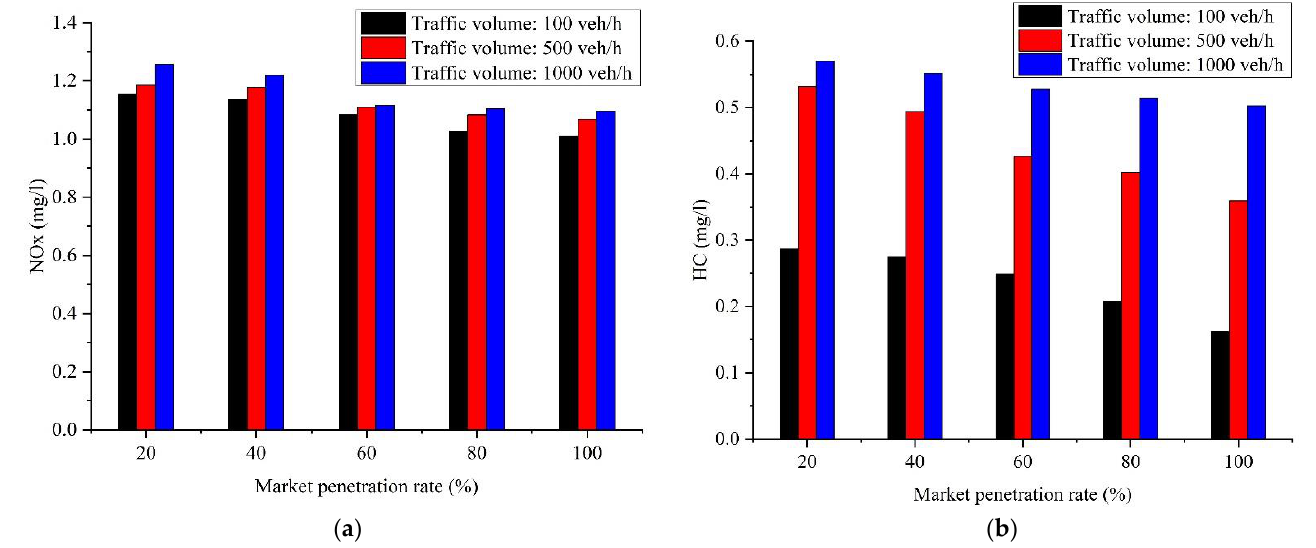
Figure 9. Emissions with different market penetration rates and real traffic volumes: ( a ) NOx; ( b ) HC.